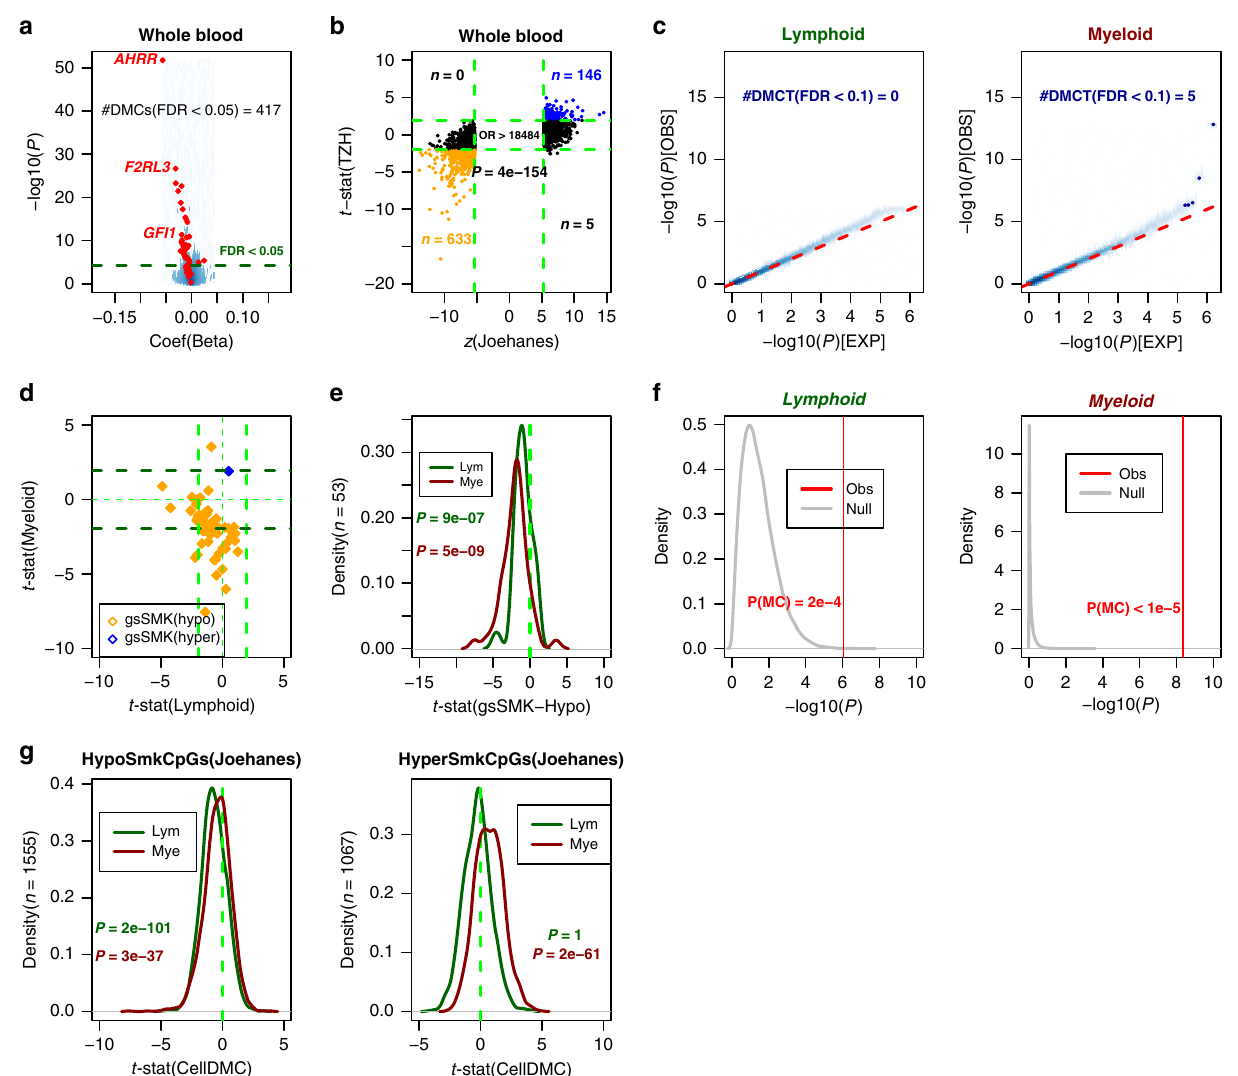
Fig. 1 Blood lineage speci fi c smoking-associated DNAm changes in TZH cohort. a Volcano scatterplot for 811,902 CpGs displaying the estimated coef fi cient ( x -axis) and − log 10 P value ( y -axis) derived from a linear model of DNAm against smoking status. Dashed line denotes FDR = 0.05, and in red we highlight the set of 62 gold-standard smoking-associated CpGs. The number of DMCs passing FDR < 0.05 is given. b Scatterplot of z -statistics of the 2622 smoking-associated CpGs from the meta-analysis of Joehanes et al. ( x -axis) vs. their corresponding t -statistics in the TZH cohort. Odds ratio (OR) and one-tailed Fisher-test P value are given. Consistently hypermethylated and hypomethylated CpGs are shown in blue and orange, respectively. Vertical and horizontal green dashed lines represent the Bonferroni and FDR < 0.05 signi fi cance levels in the Joehanes and TZH, respectively. The number of CpGs in each signi fi cant quadrant are indicated by “ n ” . c Quantile – quantile plots displaying the results of CellDMC for the lymphoid and myeloid cell-types, as indicated. Red dashed line indicates the line where observed P values match the expected ones under the null-hypothesis of no global association between smoking and differential DNAm in the respective cell-type. Blue data points represent the DMCTs passing an FDR < 0.3 threshold. d Scatterplot of CellDMC-derived t -statistics of smoking-associated differential DNAm in lymphoid cell-type ( x -axis) vs. the corresponding t -statistic in myeloid cell-type ( y -axis). Dashed lines represent the P = 0.05 thresholds, and t = 0. In orange (blue) we depict the gold-standard smoking-associated CpGs that passed QC and that are hypomethylated (hypermethylated) in smokers. e Density distributions of CellDMC-derived t -statistics of smoking-associated differential DNAm in the TZH cohort for 53 gold-standard smoking hypomethylated CpGs in the lymphoid and myeloid lineages, as indicated. P value derives from a one-tailed Wilcoxon test, testing that these gold-standard CpGs do exhibit a signi fi cant trend toward hypomethylation. f Monte-Carlo signi fi cance analysis of hypomethylation trends for the 53 gold-standard hypomethylated smoking-CpGs. Density plots of the − log 10 P values derived from a one-tailed Wilcoxon rank sum test to determine if the t -statistics of association between DNAm and smoking of 53 randomly selected CpGs is signi fi cantly less than zero, for a total of 100,000 Monte-Carlo runs ( “ Null ” , gray). The vertical red line indicates the corresponding one-tailed P value for the 53 gold-standard hypomethylated smoking-CpGs from Gao and Brenner. P values in red are derived from the Monte-Carlo analysis. All the data in this fi gure derives from analysis in our Chinese cohort. g Density distributions of CellDMC-derived t -statistics of smoking-associated differential DNAm in the TZH cohort for the 2622 gold-standard smoking CpGs from Joehanes et al in the lymphoid and myeloid lineages, as indicated. The 2622 CpGs have been split according to hypo (left) or hypermethylation (right) in the Joehanes meta-analysis study. P values derive from a one-tailed Wilcoxon test, testing that these gold- standard CpGs do exhibit a signi fi cant trend towards hypo-or-hypermethylation, as